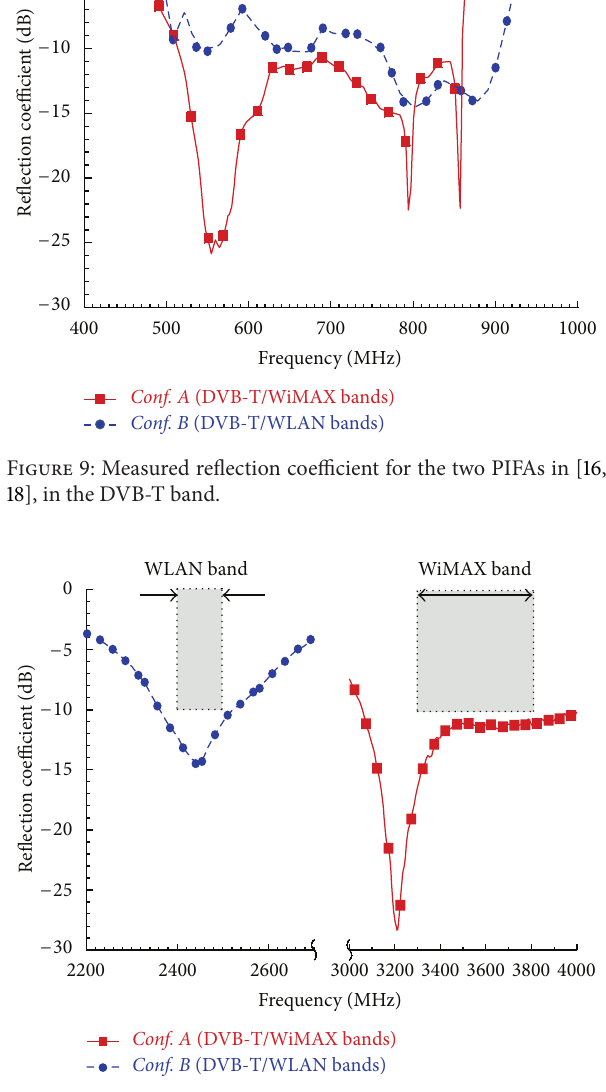
Figure 10: Measured reflection coefficient for the two PIFAs in [16, 18], in the WiMAX and WLAN bands,